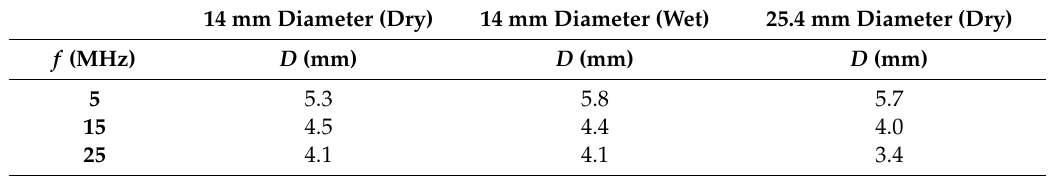
Table 2. Distance ( D ) between the location of the maximum and the minimum of normal motion.